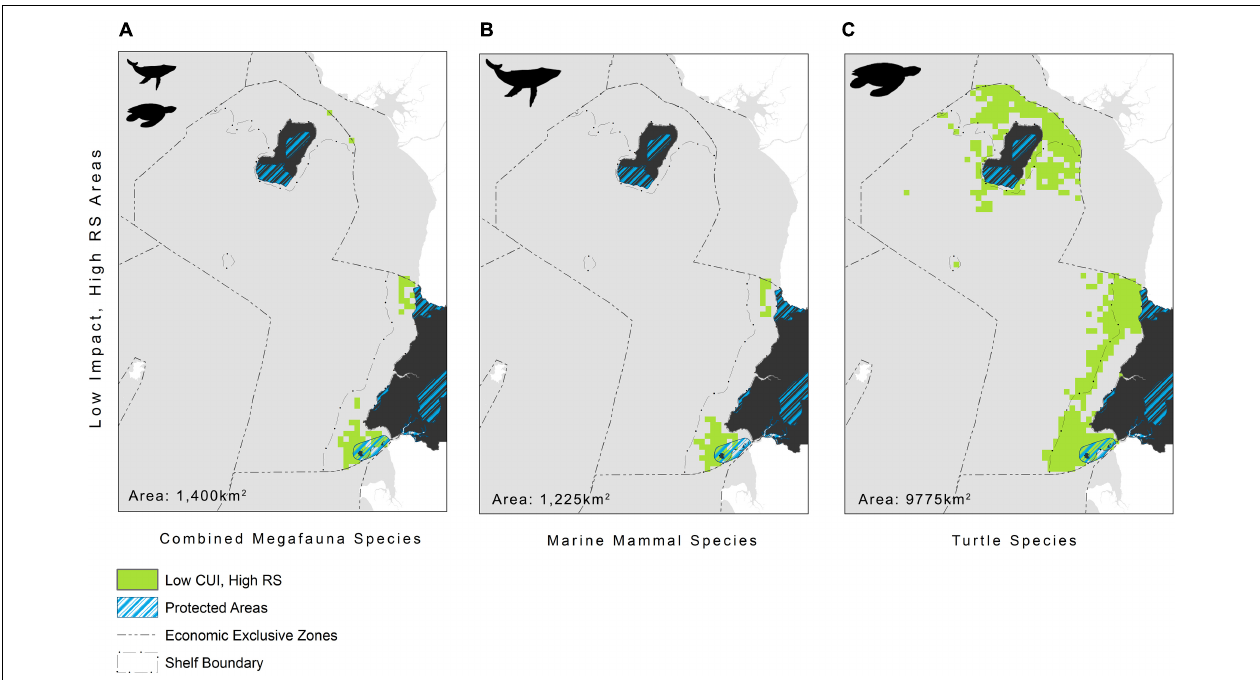
FIGURE 5 | Areas where low impact (CUI scores ≤ 50%) and high relative habitat suitability (RS ≥ 75%) overlap, representing areas needing protection, for: (A) all megafauna species ( n = 5: humpback whale, bottlenose and Atlantic humpback dolphin, leatherback and olive ridley sea turtles); (B) marine mammals ( n = 3: humpback whale, bottlenose and Atlantic humpback dolphin); and (C) sea turtles ( n = 2: leatherback and olive ridley sea turtles) within Equatorial Guinea’s exclusive economic zone. See Figure 1 for additional geographical information for the Bioko-Corisco-Continental area of Equatorial Guinea’s exclusive economic zone. TABLE 3 | Influence of individual CUI layers on overall CUI distributions for marine mammals, sea turtles, and combined megafauna species. Influence on CUI R 2 Marine mammals Sea turtles All megafauna